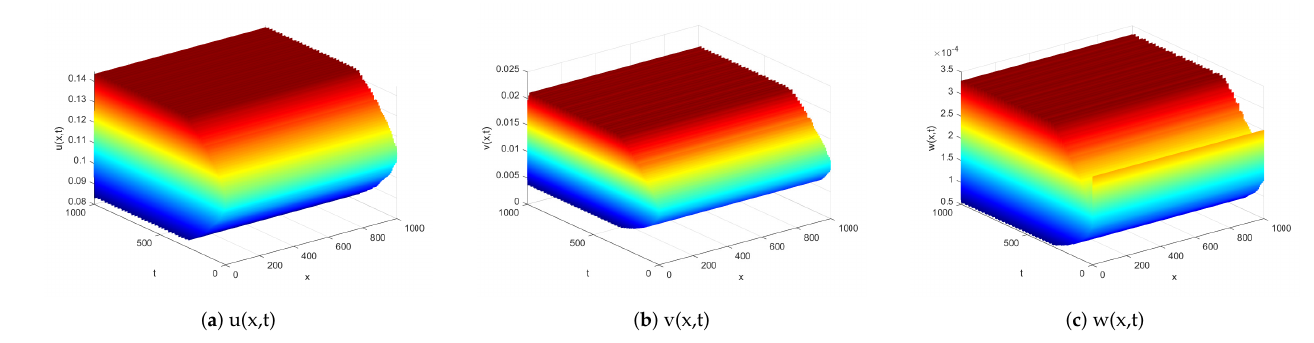
Figure 3. For d 1 = d 2 = d 3 , ( u p ( t ), v p ( t ), w p ( t )) is still stable in system (3).